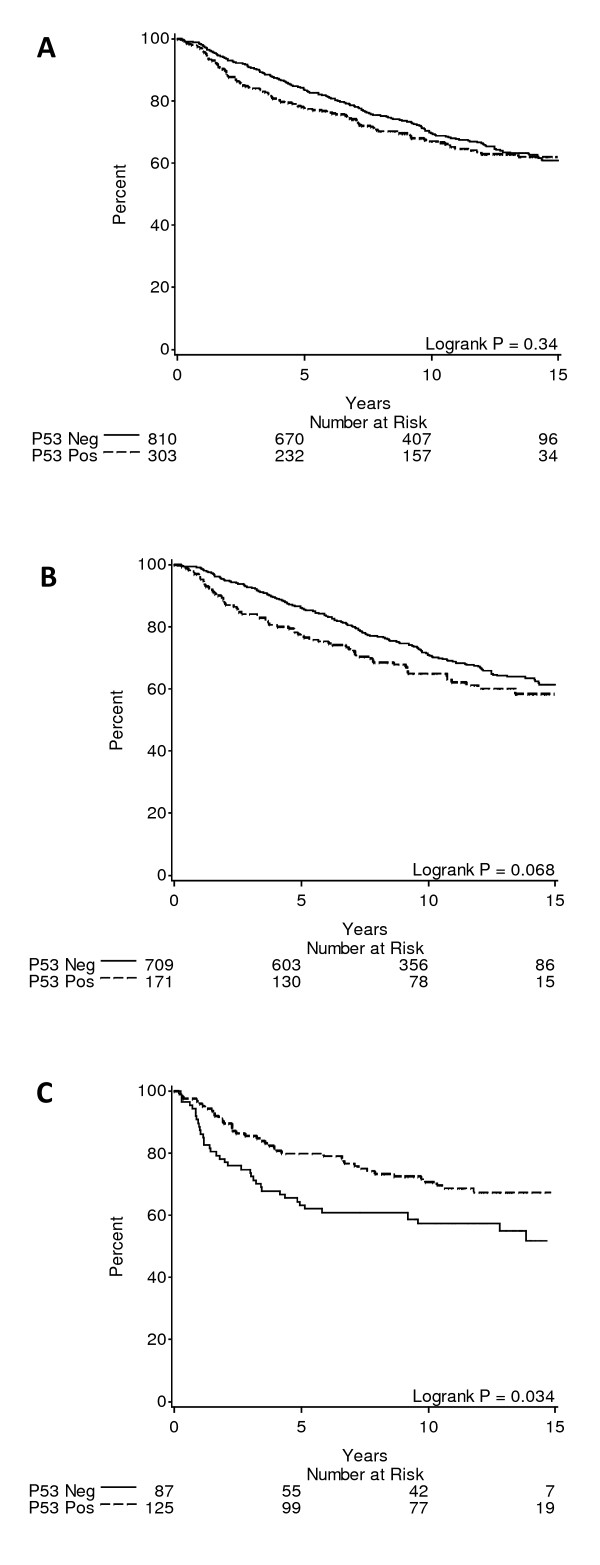
Disease-free survival by p53 expression (≥ 10%) at 12-year median follow-up. (A) All analysed patients. (B) Patients whose tumors expressed estrogen receptor (ER). (C) Patients whose tumors did not express ER.